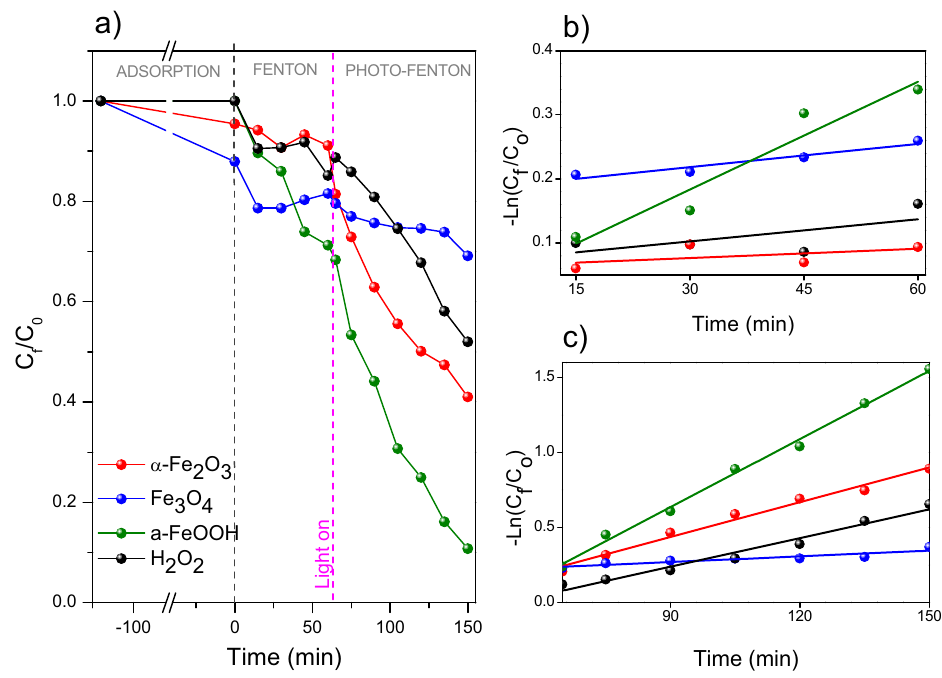
Figure 5: ( a ) MB discoloration in iron oxide catalysts with 120 min of adsorption, 60 min of Fenton reaction followed by 90 min of photo - Fenton reaction for a system containing 20 mg of catalyst, 15 mL of 25 mg L − 1 of MB and 1 mL of H 2 O 2 30% by weight. Linear regression of the MB photo - Fenton - like discoloration for: ( b ) Fenton and ( c ) photo - Fenton